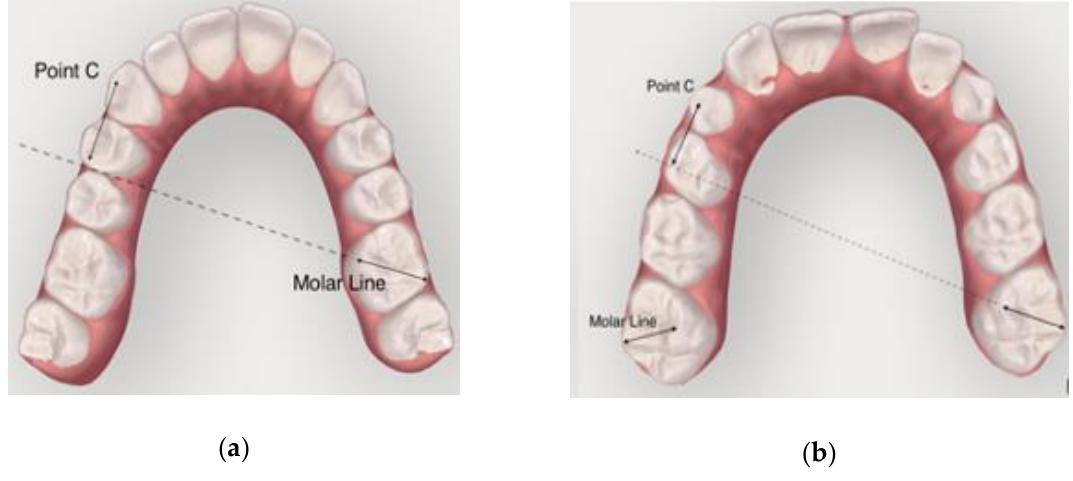
Figure 1. Ricketts’method to detect a mesiorotated upper first molar in ( a ) permanent dentition and ( b ) mixed dentition. and ( b ) mixed